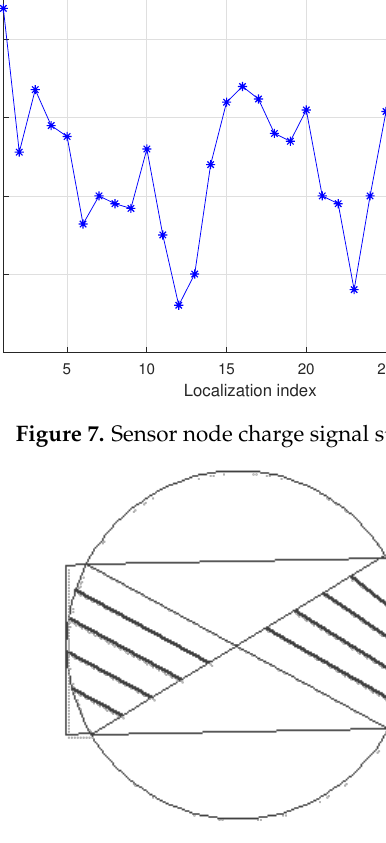
Figure 8. Charging coverage in rectangular